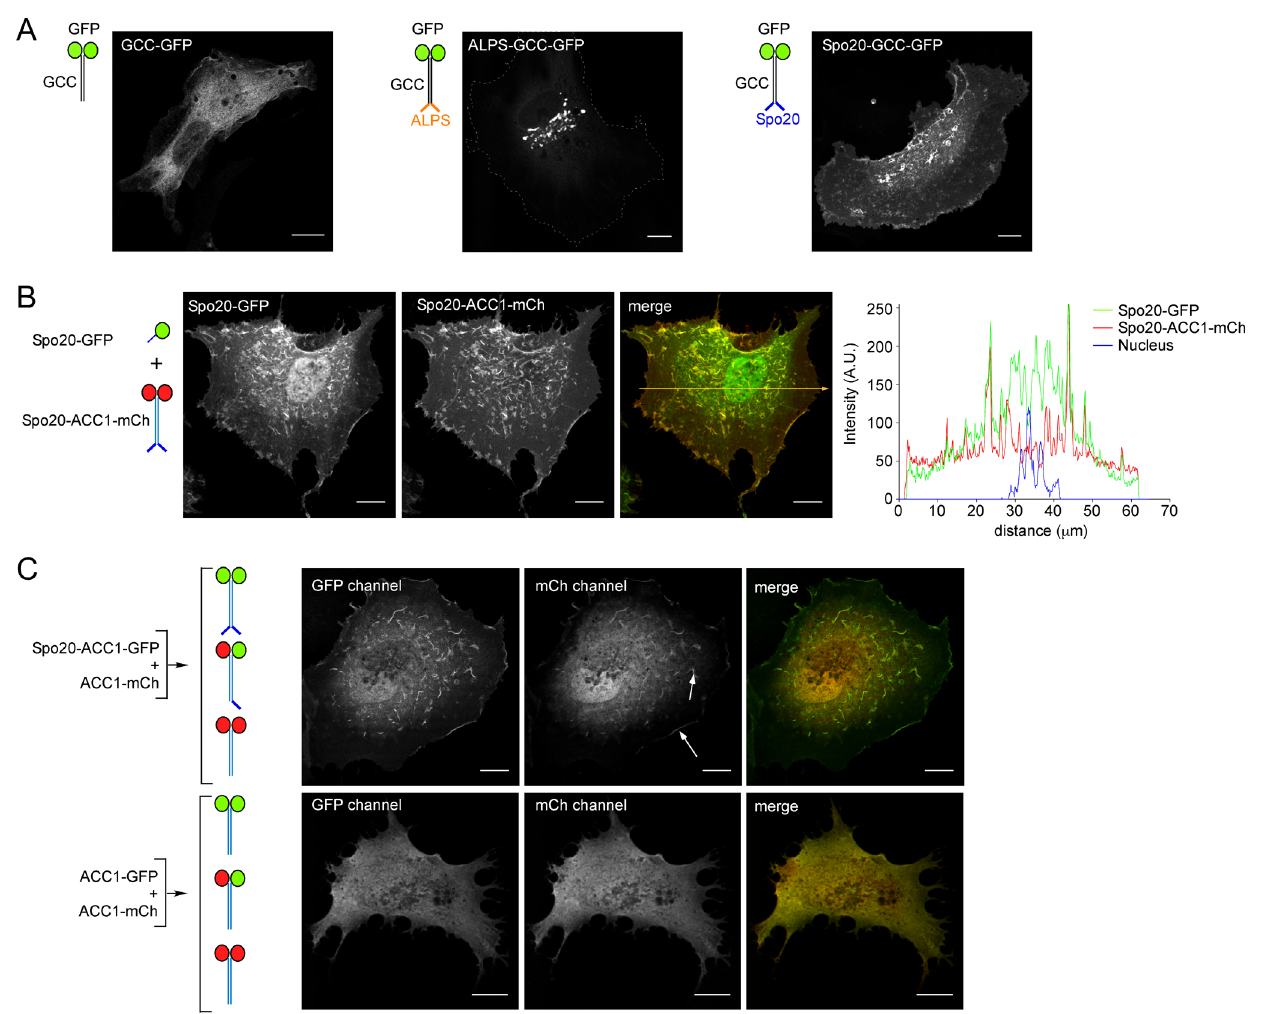
Figure 3. Subcellular localization of coiled-coil bioprobes containing ALPS or the Spo20 membrane sensor region. ( A ) GCC-GFP, ALPS-GCC-GFP or Spo20-GCC-GFP in RPE1 cells. ( B ) Coexpression of monomeric Spo20-GFP and Spo20-ACC1-mCherry. The two constructs labeled the same membrane structures (plasma membrane ruffles), but Spo20-GFP also invades the nucleus and is more cytosolic than Spo20-ACC1-mCherry. ( C ) Coexpression of Spo20-ACC1-GFP and ACC1-mCherry or ACC1-GFP and ACC1-mCherry. Due to dimerisation, three coiled-coil probes should form with different color properties and various numbers of Spo20 membrane sensor regions. The moderate labeling of plasma membrane ruffles by mCherry (arrows) indicates that the heterodimer Spo20-ACC1-GFP/ACC1-mCherry, which contains one Spo20 motif, binds membranes. Scale bars, 10 m